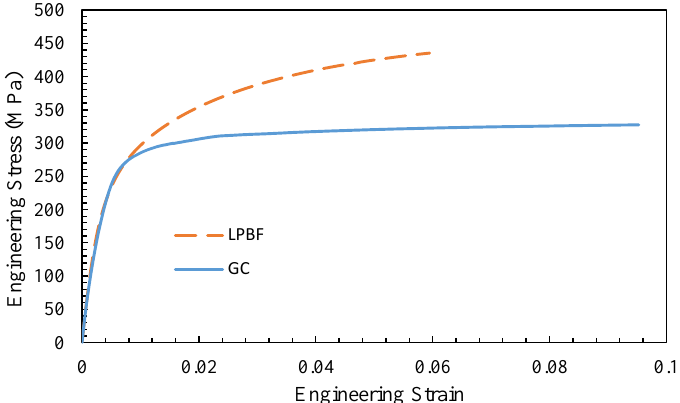
Figure 6. Experimental results of the uniaxial tensile tests for GC and LPBF AlSi10Mg.